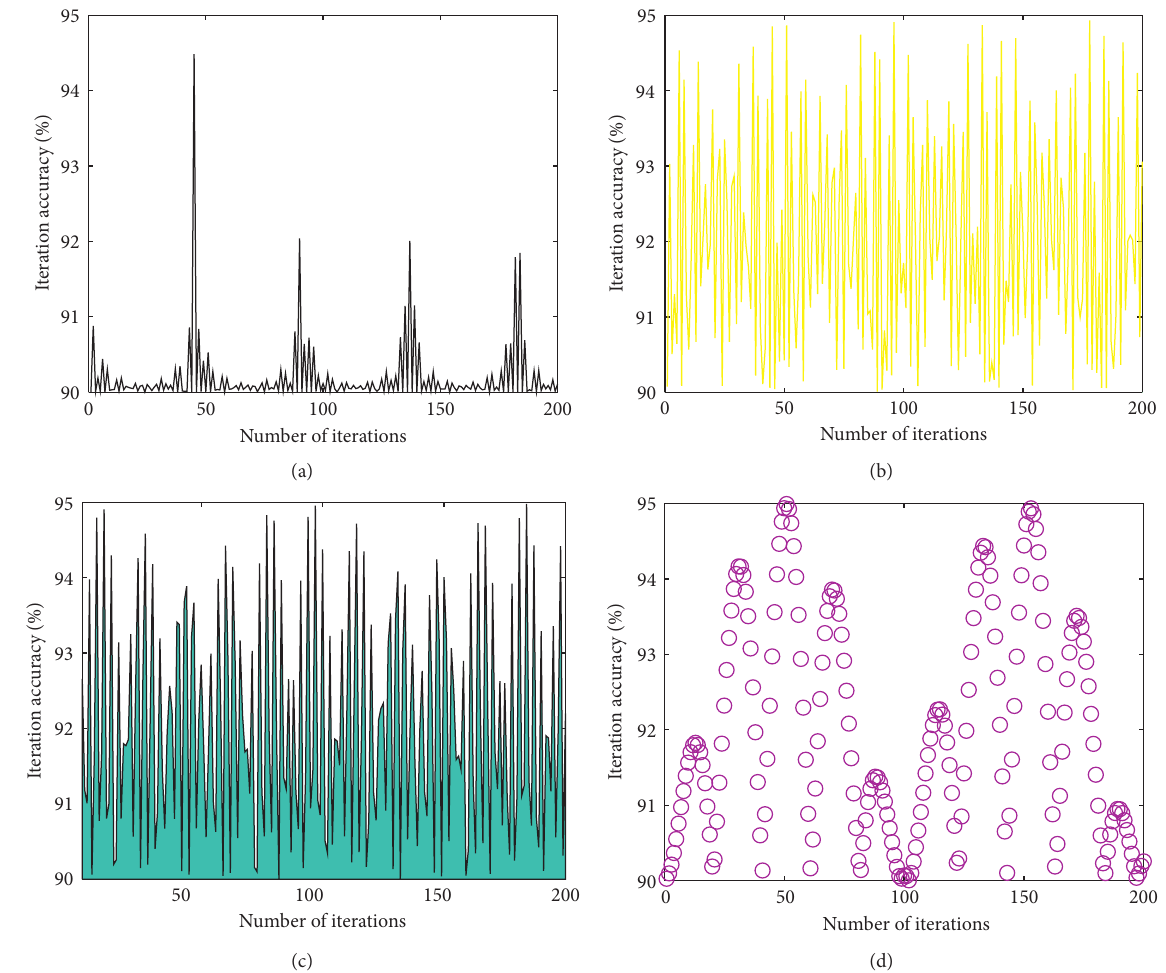
Figure 5: The accuracy of Newton iteration generated by different iteration functions. (a) Power function Newton iteration accuracy rate. (b) Trigonometric function Newton iteration accuracy rate. (c) Exponential function Newton iteration accuracy rate. (d) Hyperbolic function Newton iteration accuracy